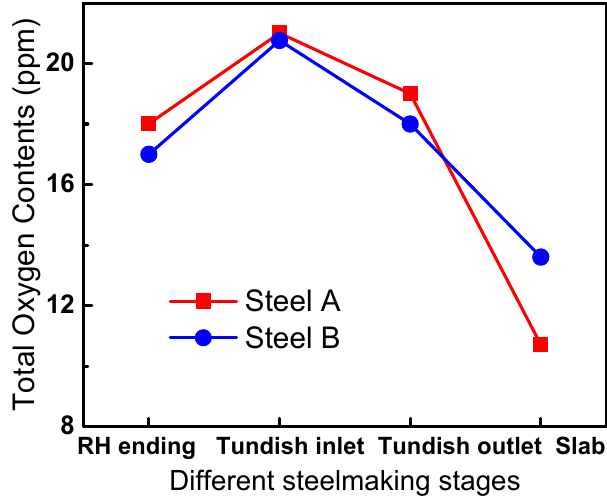
Figure 2. Changes in total oxygen content at different steelmaking stages.